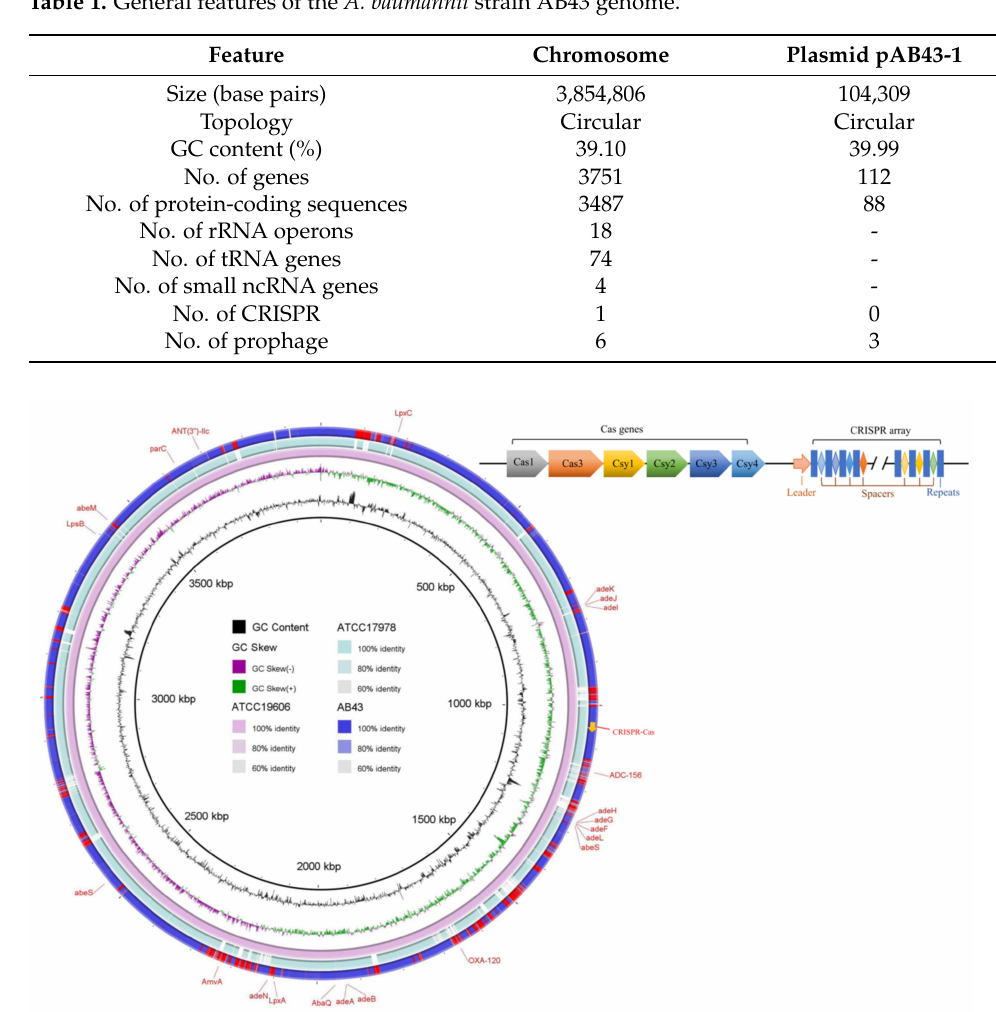
Figure 2. Basic information of the Acinetobacter baumannii strain AB43 chromosome. The ring diagram shows the comparison of three A. baumannii strain (AB43, ATCC19606, ATCC17978) chromosomes containing (or not containing) different CRISPR-Cas systems. AB43 contains type I-Fb CRISPR-Cas system, ATCC19606 contains type I-Fa CRISPR-Cas system, ATCC17978 did not contain CRISPR-Cas system. Rings from inside to outside: (1) the G + C content; (2) the GC skew; green and purple represent the GC skew (+) and GC skew ( − ), respectively; (3) A. baumannii ATCC19606 chromosome; (4) A. baumannii ATCC17978 chromosome; (5) clinical isolate A. baumannii AB43 chromosome. The genes associated with drug resistance and the CRISPR-Cas system in A. baumannii AB43 were marked in the figure. The AB43 CRISPR-Cas system is composed of cas genes, leader sequences, and CRISPR array. Type I system signature gene, cas3 , is shown (orange). CRISPR arrays are composed of repeats (blue rectangle) and spacers (colored diamond). These repeats are separated by unique